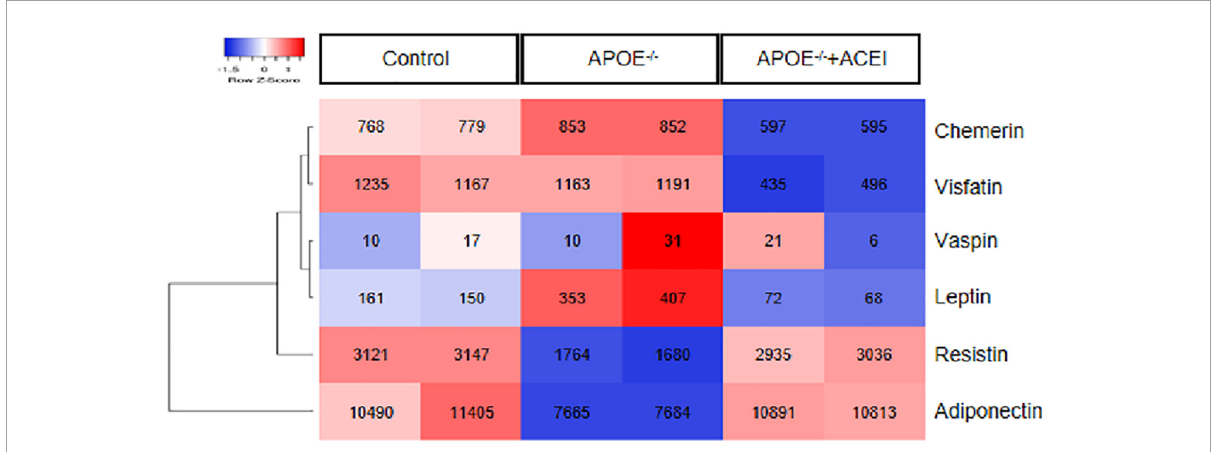
FIGURE1 The expression of genes encoding adipokines. The heatmap depicts the down-regulated (blue) and up-regulated (red) expression of the adipokines, including adiponectin, visfatin, leptin, resistin, chemerin, and vaspin in aortas from dataset GSE19286 including APOE - / - mice in the presence or absence of ACEI and control mice ( n = 2 per condition). ACEI, angiotensin-converting enzyme